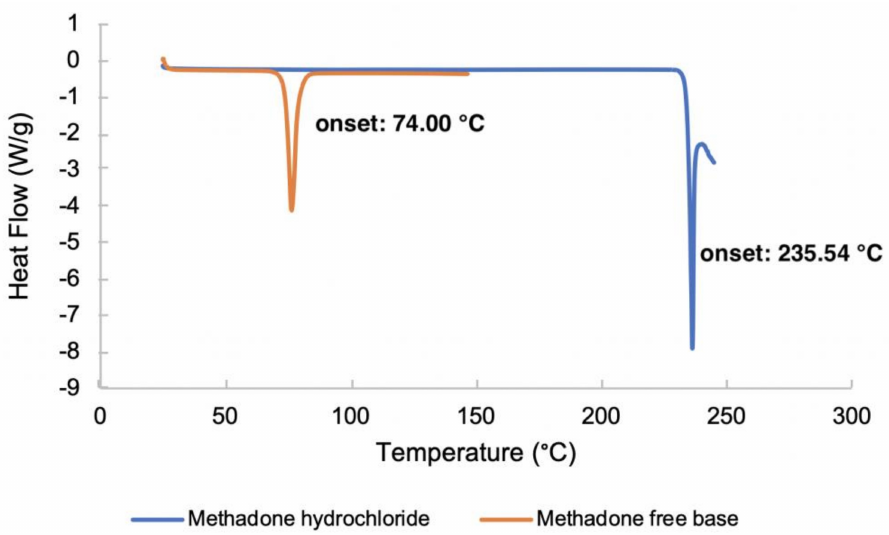
Figure 3. DSC thermograms of methadone hydrochloride and methadone free